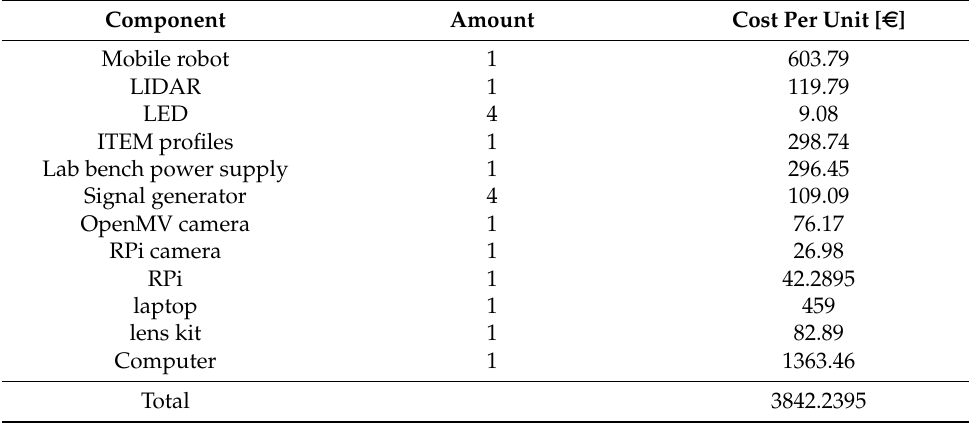
Table A1. Cost of the experimental